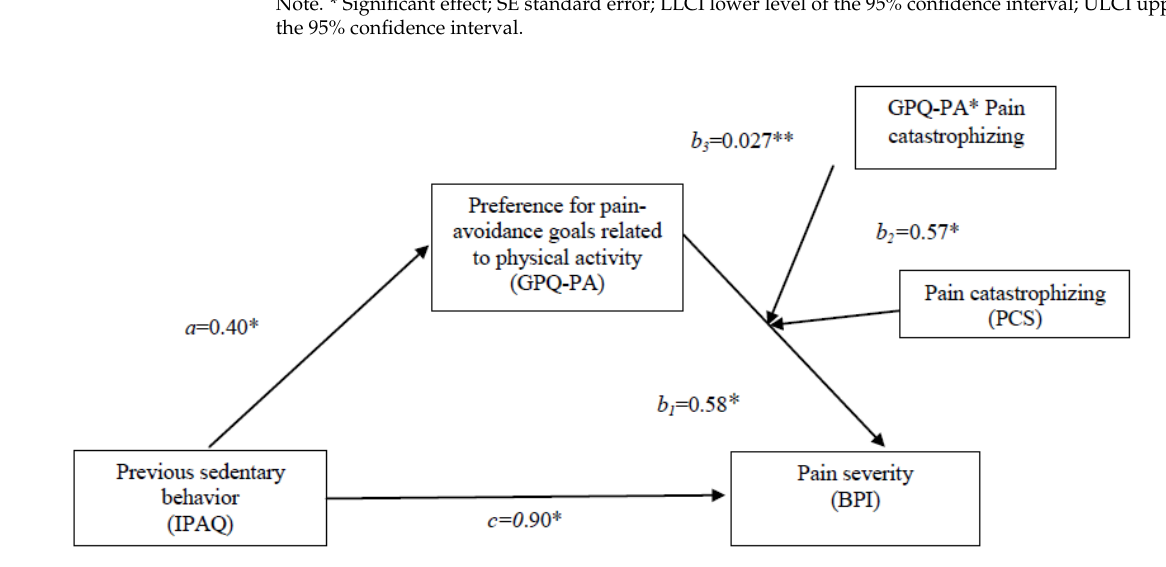
Table 3. The moderated-mediation model showed the effect of pain catastrophizing on pain per- ception via the preference for pain-avoidance goals.